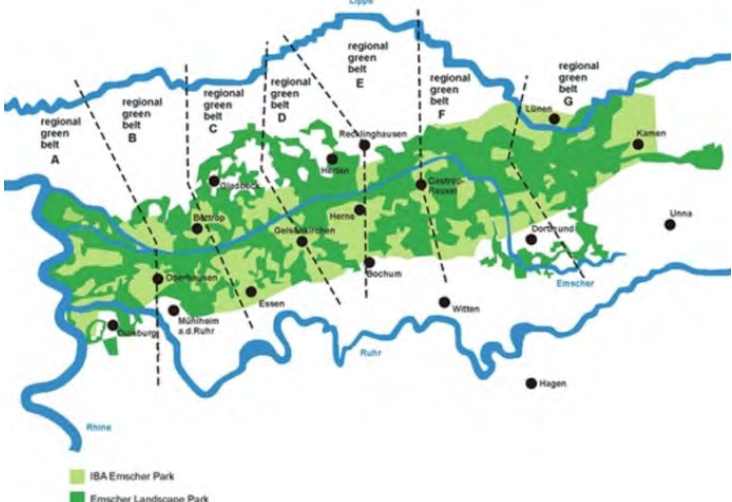
Figure 4. The master plan of the International Bauausstellung Emscher Park (Source: Gruehn, 2017).